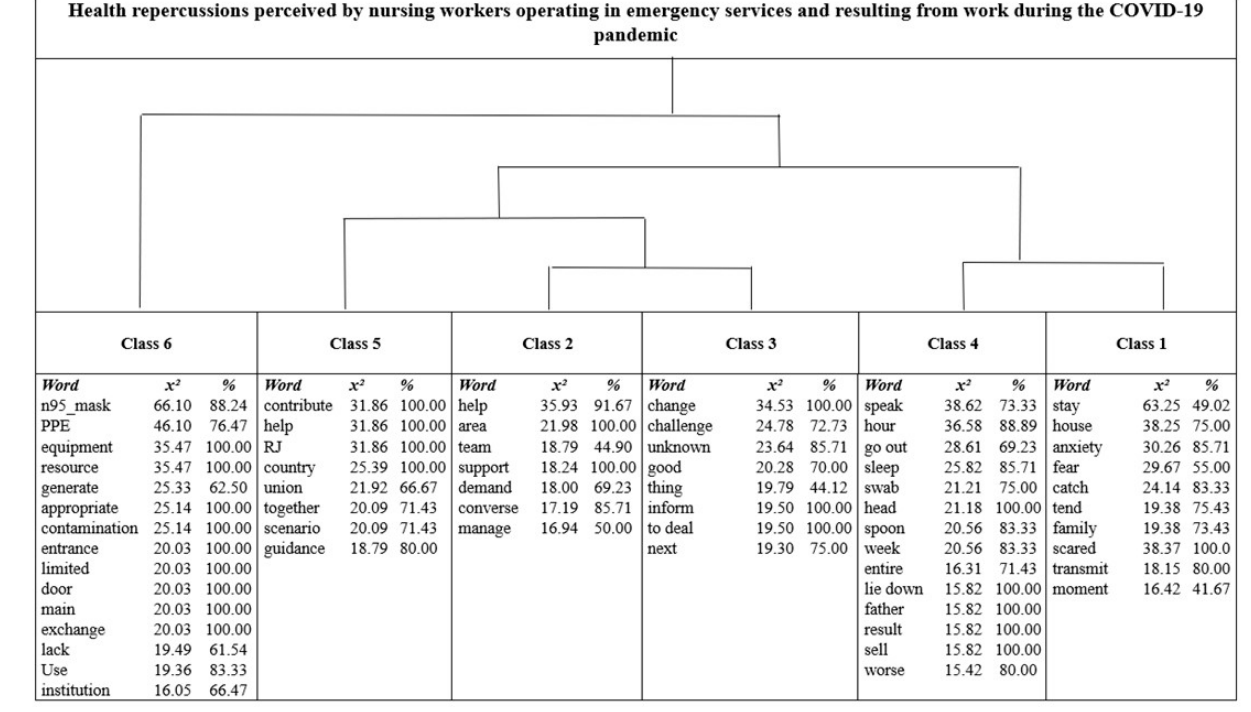
Figure 3. Dendrogram showing words that formed the study categories. Note: RJ = Rio de Janeiro.